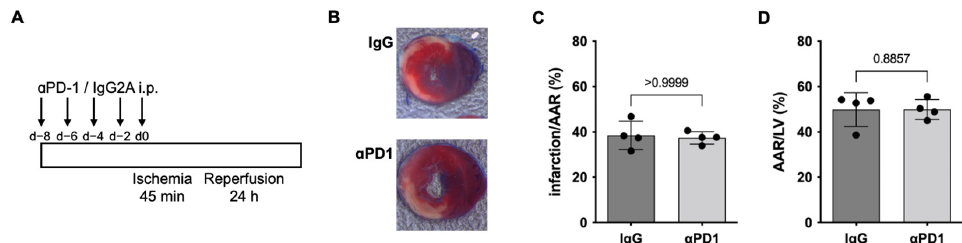
Figure 4. Infarct size in mice receiving α PD1 therapy. ( A ) Treatment scheme of mice receiving α PD1 therapy or IgG2A control followed by induction of repAMI with 24 h reperfusion. ( B ) Exemplary images and ( C , D ) quantification of infarct sizes determined by triphenyltetrazolium chloride (TTC) Evans’s blue staining ( n = 4 per group). Black dots indicate individual samples.